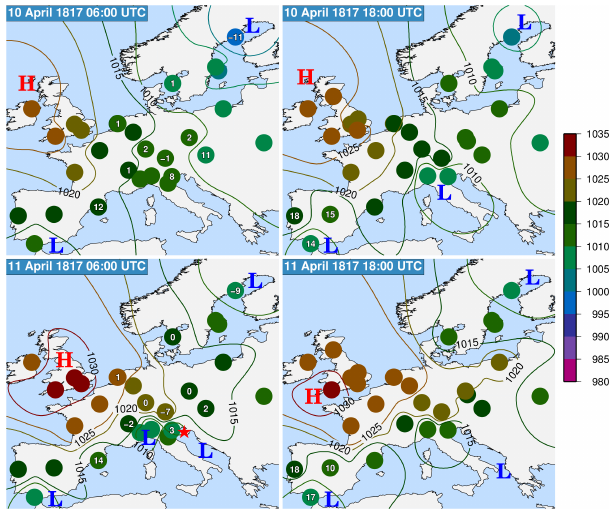
Figure 13. Similar to Fig. 9 but showing maps for 25–27 April 1817 at 12h interval. A star marks the position of the frigate Austria on the morning of 27